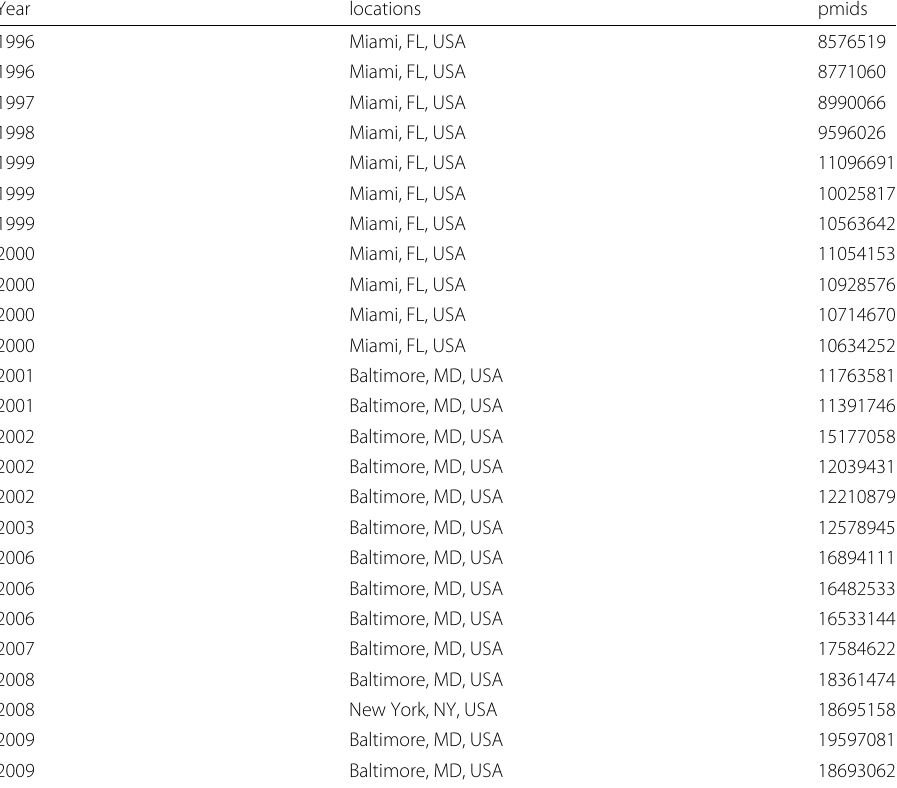
Table 3 Example of career path of a specific author (Lisa M. Shulman). For each record we have the year of publication, the city of the affiliation and the relative PubMed ID identifying the paper. The algorithm would record a move from Miami to Baltimore in 2001 and no moves in any other years ( Continued )